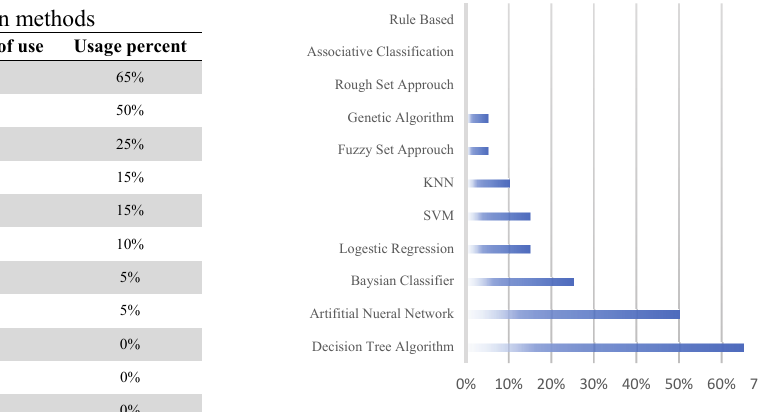
Fig. 8. Comparison of the classification methods